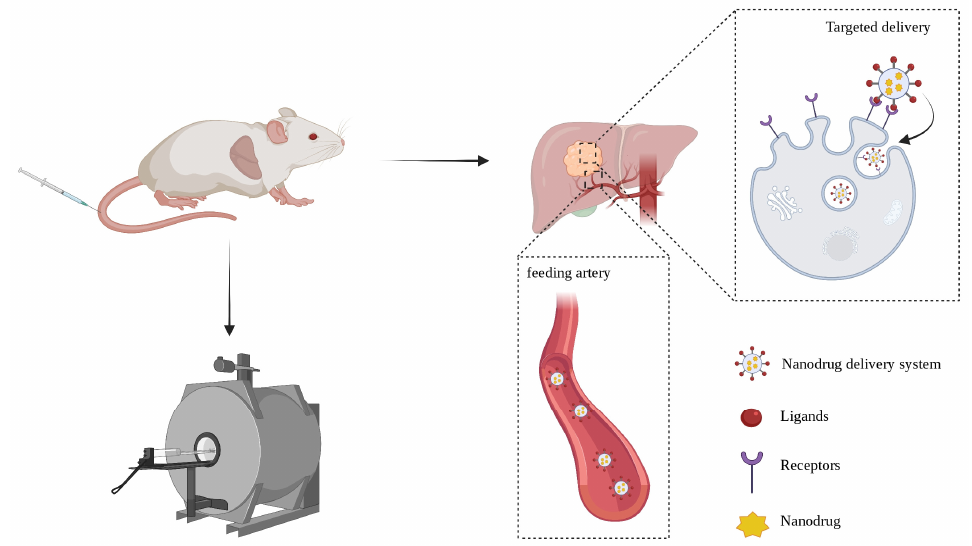
Figure 1 Figure 1. The schematic diagram of nanodrug targeted delivery.